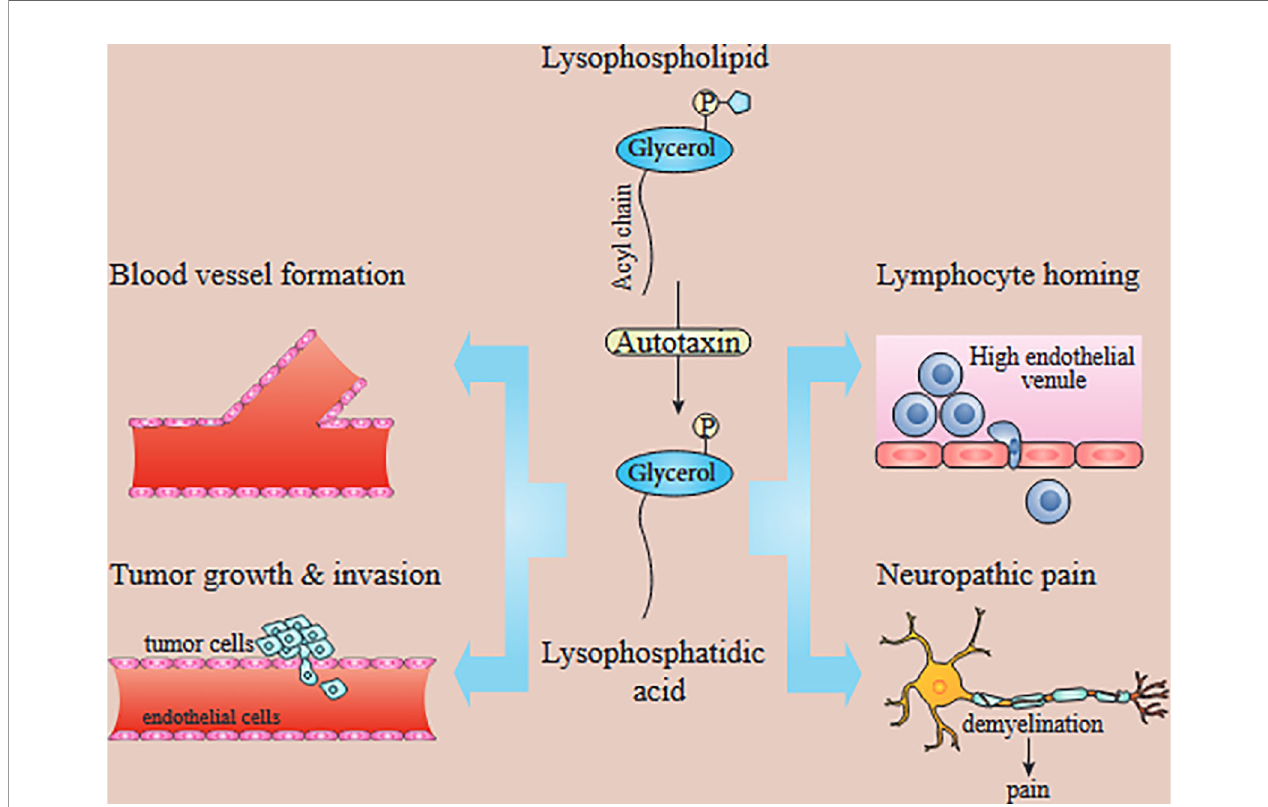
FIGURE 1 | In vivo functions of the ATX/LPA axis. LPA produced by ATX has been implicated in blood vessel formation, neuropathic pain, lymphocyte homing, and tumor growth and metastasis. Autotaxin-produced lysophosphatidic acid is involved in tumor development, angiogenesis, metastasis, lymphocyte homing, and neuropathic pain [39 – 41]. While LPAR1 is known to promote tumor metastasis and neuropathic pain, the exact LPA receptors contributing to other processes are